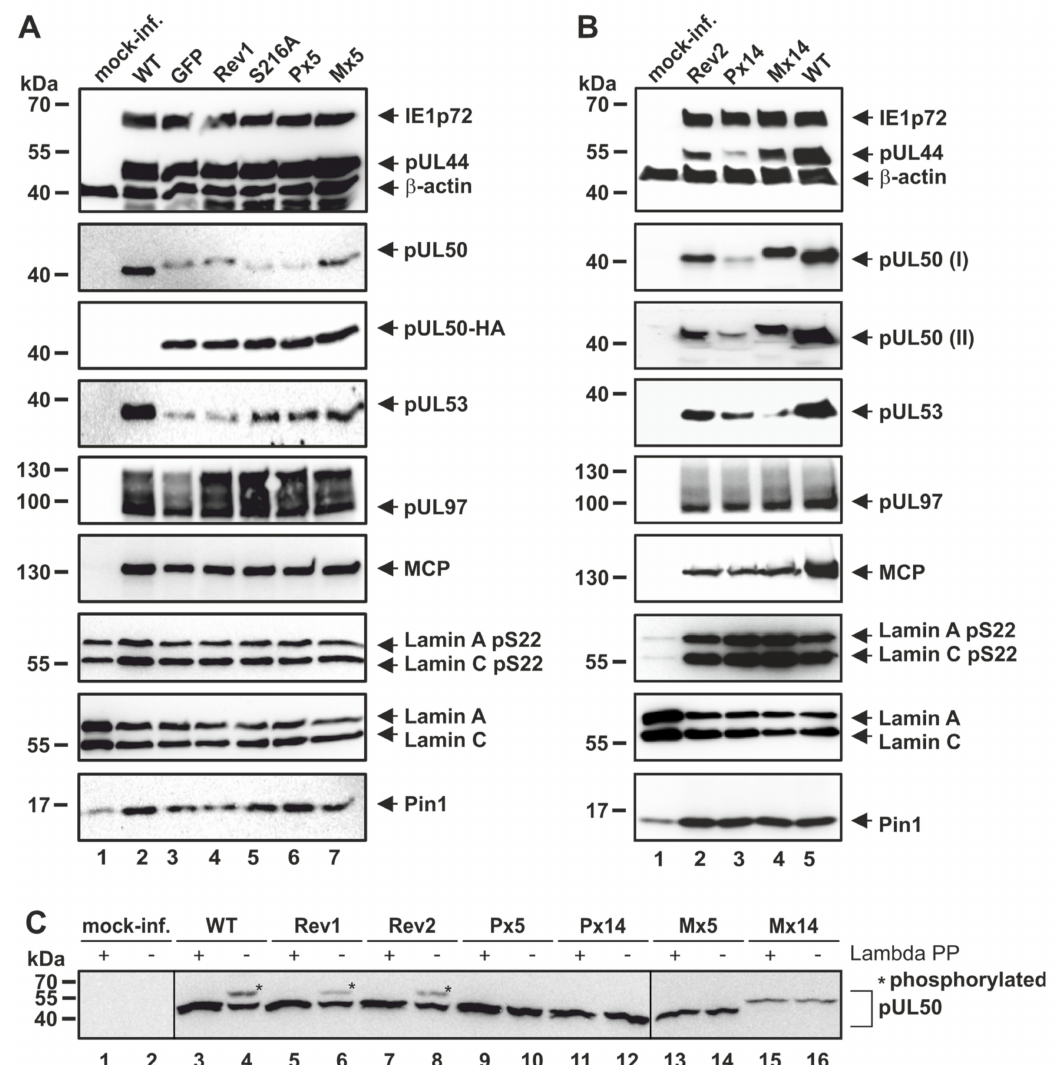
Figure 3. Analysis of viral protein expression of HCMV pUL50 phosphosite mutants. HFFs were infected with parental or recombinant HCMVs at a MOI of 0.3. Protein expression was analyzed after 4 d p.i. and Wb was performed using the indicated antibodies. ( A ) Focus was given either to major phosphosite mutants P × 5 and M × 5, or ( B ) the mutants including major plus minor phosphosite replacements in P × 14 and M × 14. Note the reduced pUL53 and pUL50 levels, as explained in the text, the latter depicted by two independent experimental replicates, labeled pUL50 (I) and (II). ( C ) Total lysates of HCMV-infected HFFs were optionally treated with lambda phosphatase (PP) for 45 min at 30 ◦ C and subjected to Phos-tag SDS-PAGE and Wb; *, phosphorylated form of